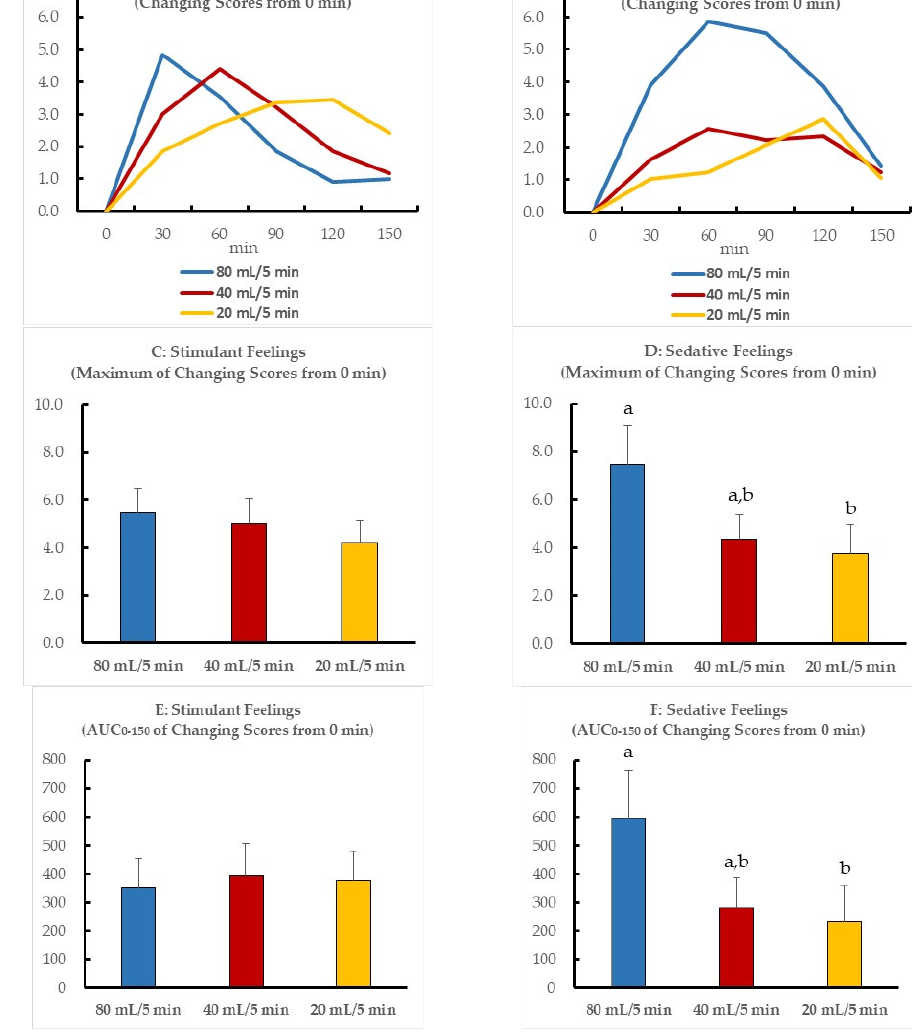
Table 4. Relationship of BAC-max with each maximal score of subjective feeling in the crossover trial. Stimulant Feelings